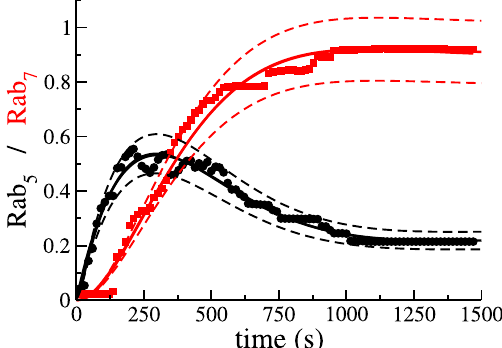
Figure 3. Cut-off switch model captures the mean and fluctuations of the experimental data. Comparison of model predictions (solid lines) as described by Eqs. (17)–(19) and the experimental data (black circles and red squares) from Ref. 10 . Solid lines correspond to the mean values of the normalised intensity of Rab5 and Rab7 fluorescence markers. Dashed lines correspond to the mean ± one standard deviation, as derived from Eqs. (S26)–(S28) in the Supplementary Information making use of the experimentally calibrated model parameters. The fluctuations predicted by the model capture consistently those of the